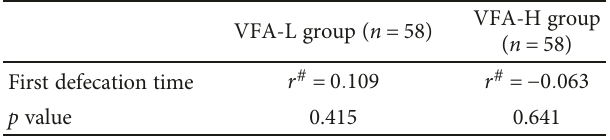
Table 5: Comparison of the postoperative outcomes between the low-VFA group and high-VFA group (cases (%)).